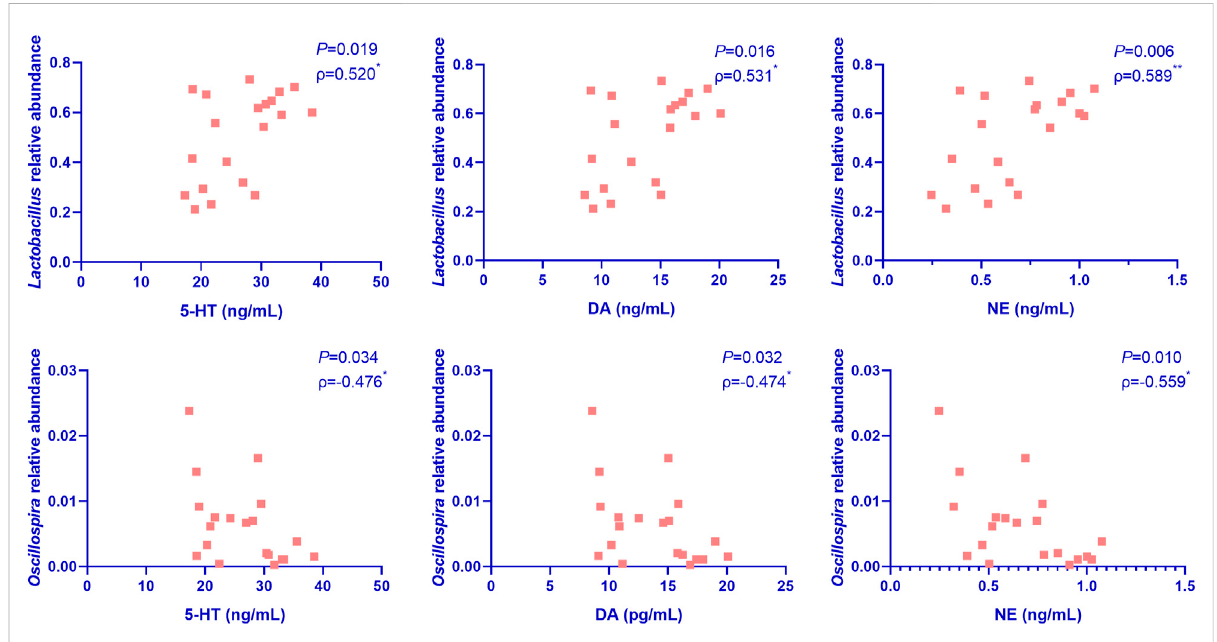
Pearson correlation analysis of the correlation between the top 20 dominant micro fl ora at the genus level and the hippocampal levels of anti- depressant factors in mice ( n = 5 per group). Nef, neferine; Flu, fl uoxetine; DA, dopamine; 5-HT, serotonin; NE, norepinephrine. The